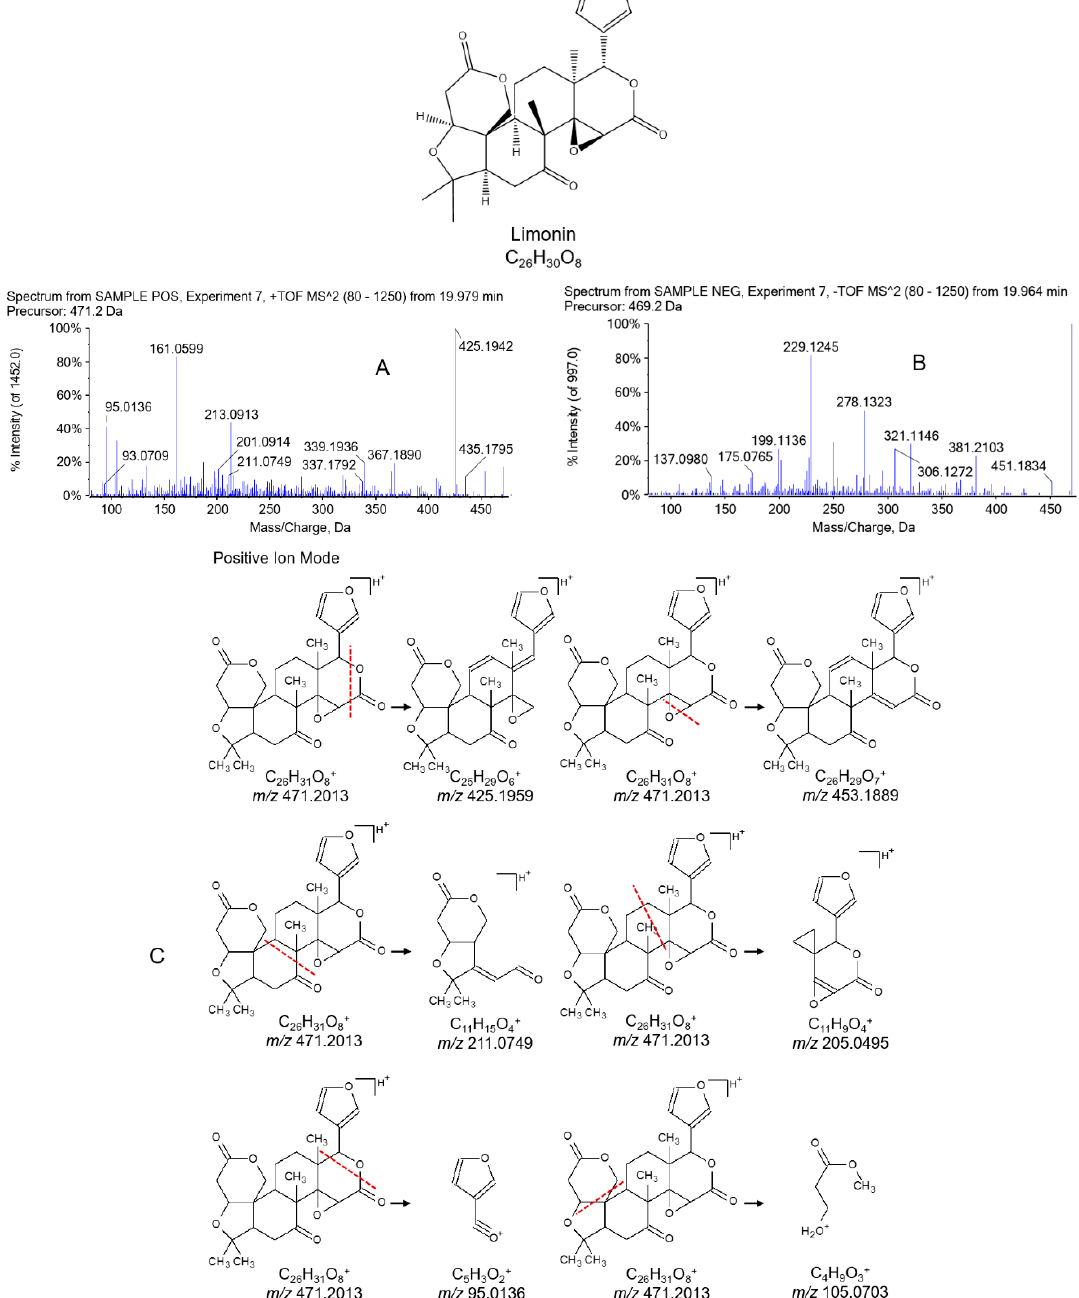
Figure 3A. The MDF and fragment filtering approach were also applied in the limonoid identification. The mass defect 0.2013 of limonin was selected as the mass defect filtering reference along with the defect tolerance of 50 mDa and the filtering mass range of 400–600 Da. The fragments of m/z 95.0136 and m/z 105.0703 in positive ion mode were adopted as the fragment filtering references.